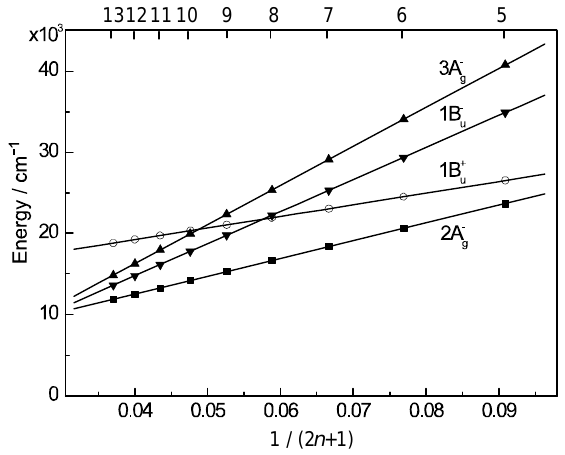
Figure 7. An energy diagram for the optically-allowed 1B u+ and optically-forbidden 2A g– , 1B u– and 3A g– states for conjugated chains having n = 5~13 double bonds (reprinted with permission from [11] © 2005, American Chemical